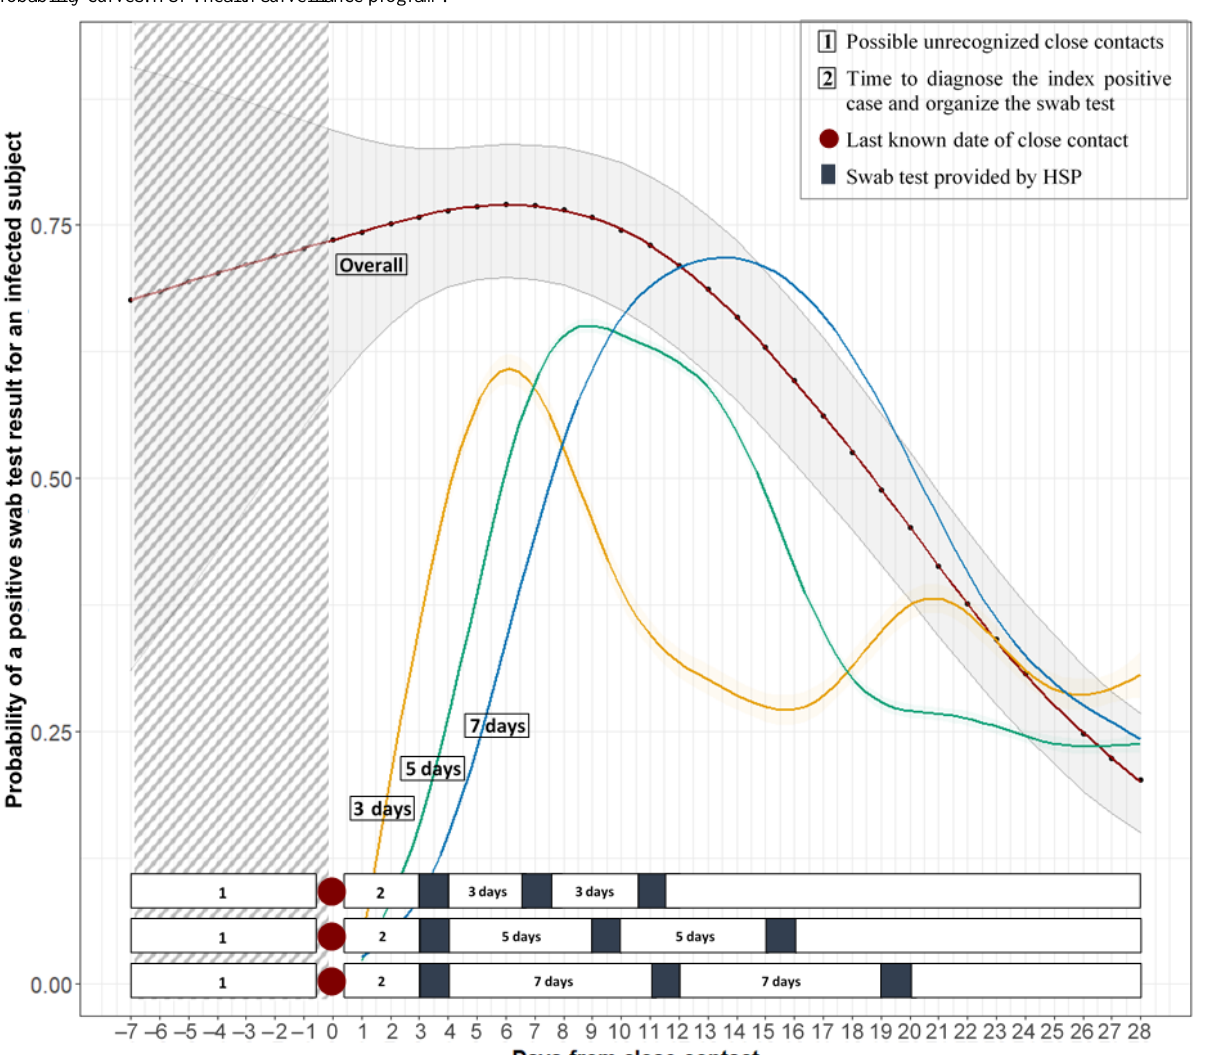
Figure 1. Graphical predictions from the generalized additive mixed models. The 4 curves represent the predicted probabilities of having a positive test related to the number of days since the last known date of close contact among all health care workers infected with SARS-CoV-2 (overall curve) and in the subgroups of those infected with SARS-CoV-2 with an initial negative swab test result in the 7-day standard surveillance interval and simulating 2 different time intervals of 3 and 5 days. The bars show the time course of the health surveillance program in the 3 different time intervals related to the probability curves. HSP: health surveillance